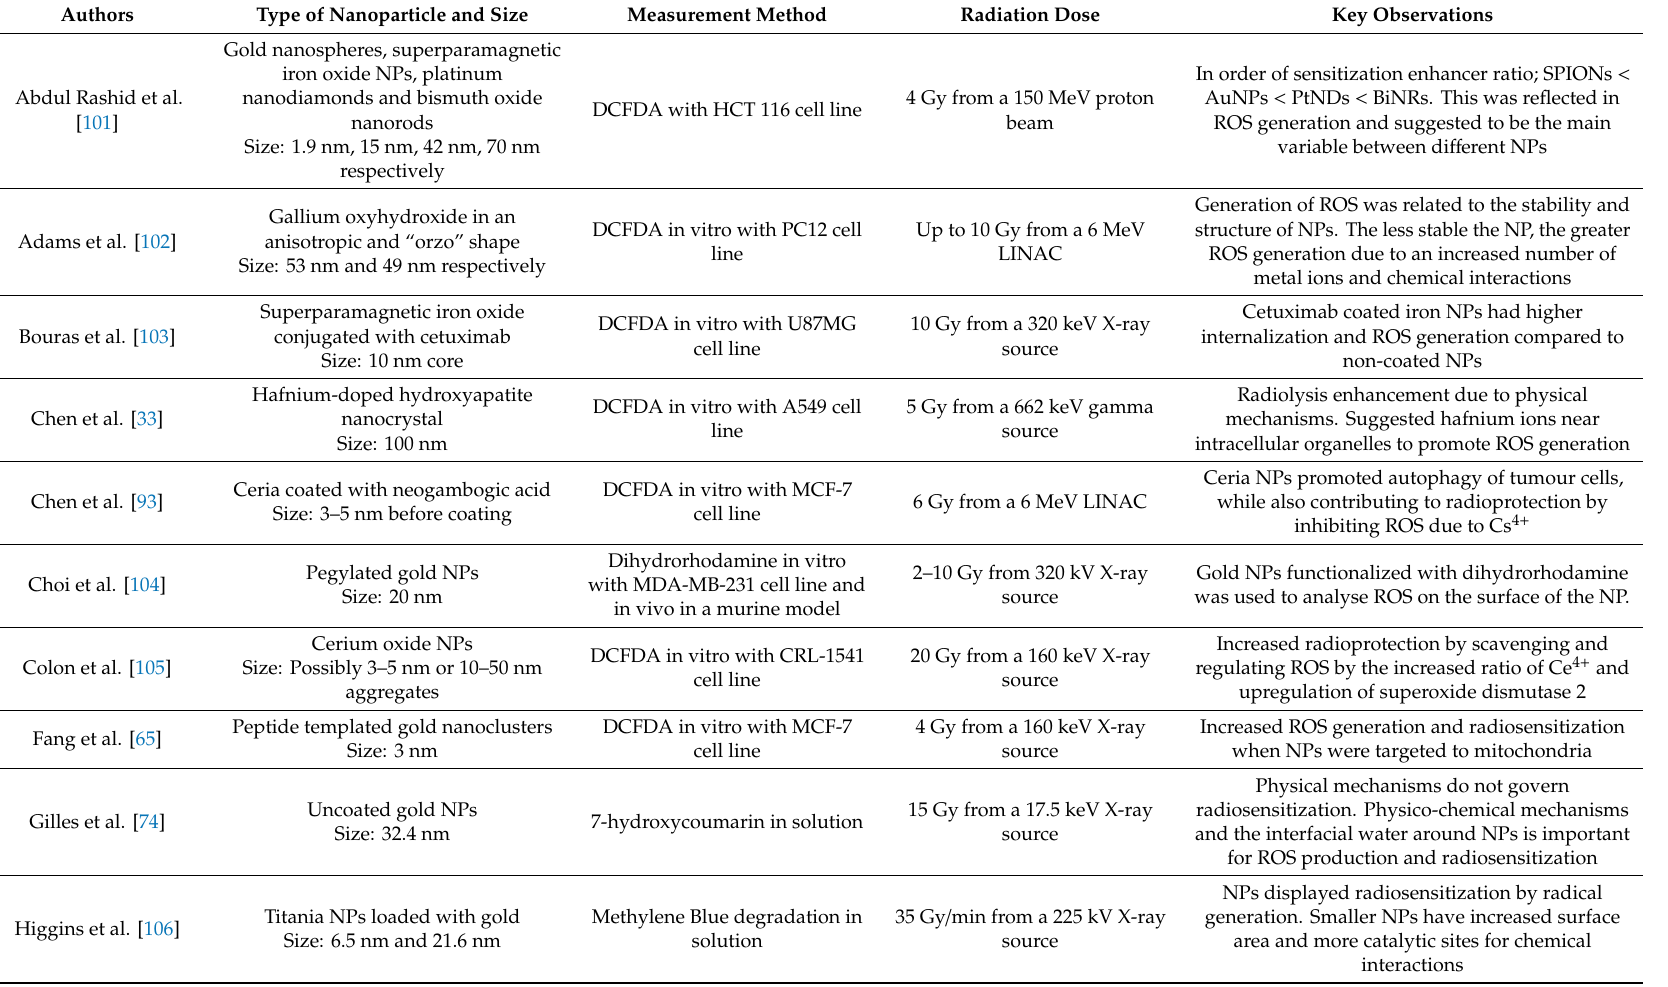
Table 2. Summary of reported ROS measurements and key observations regarding ROS using fluorescent